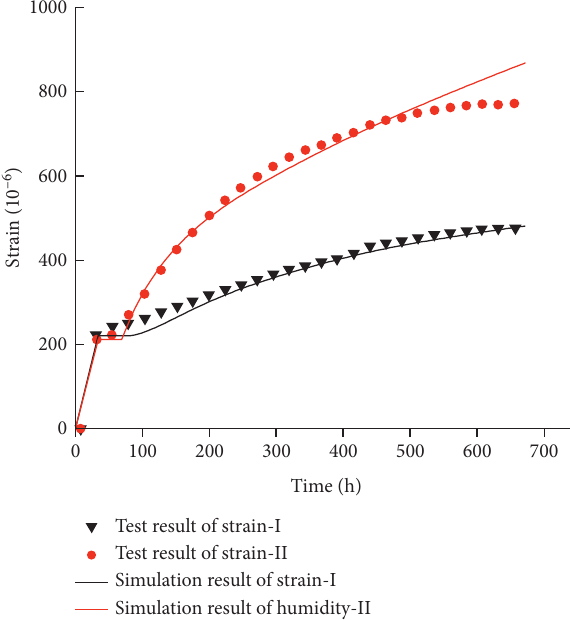
Figure 7: Development of free shrinkage strain with